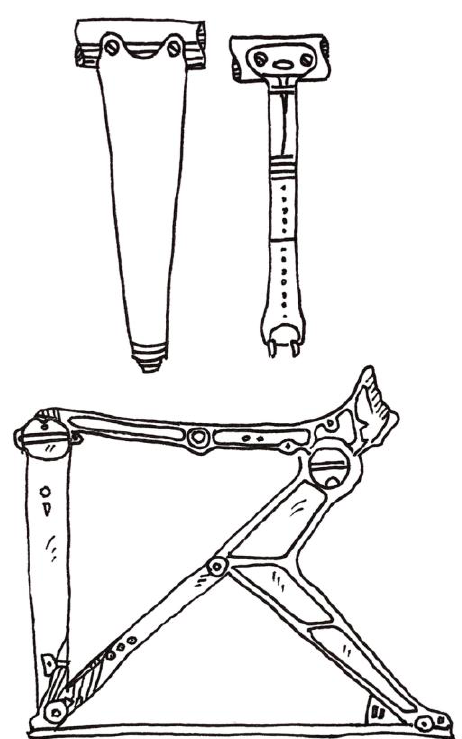
Figure 15. US Patent 4,375,300 STraditional strong triangular support structure [17].